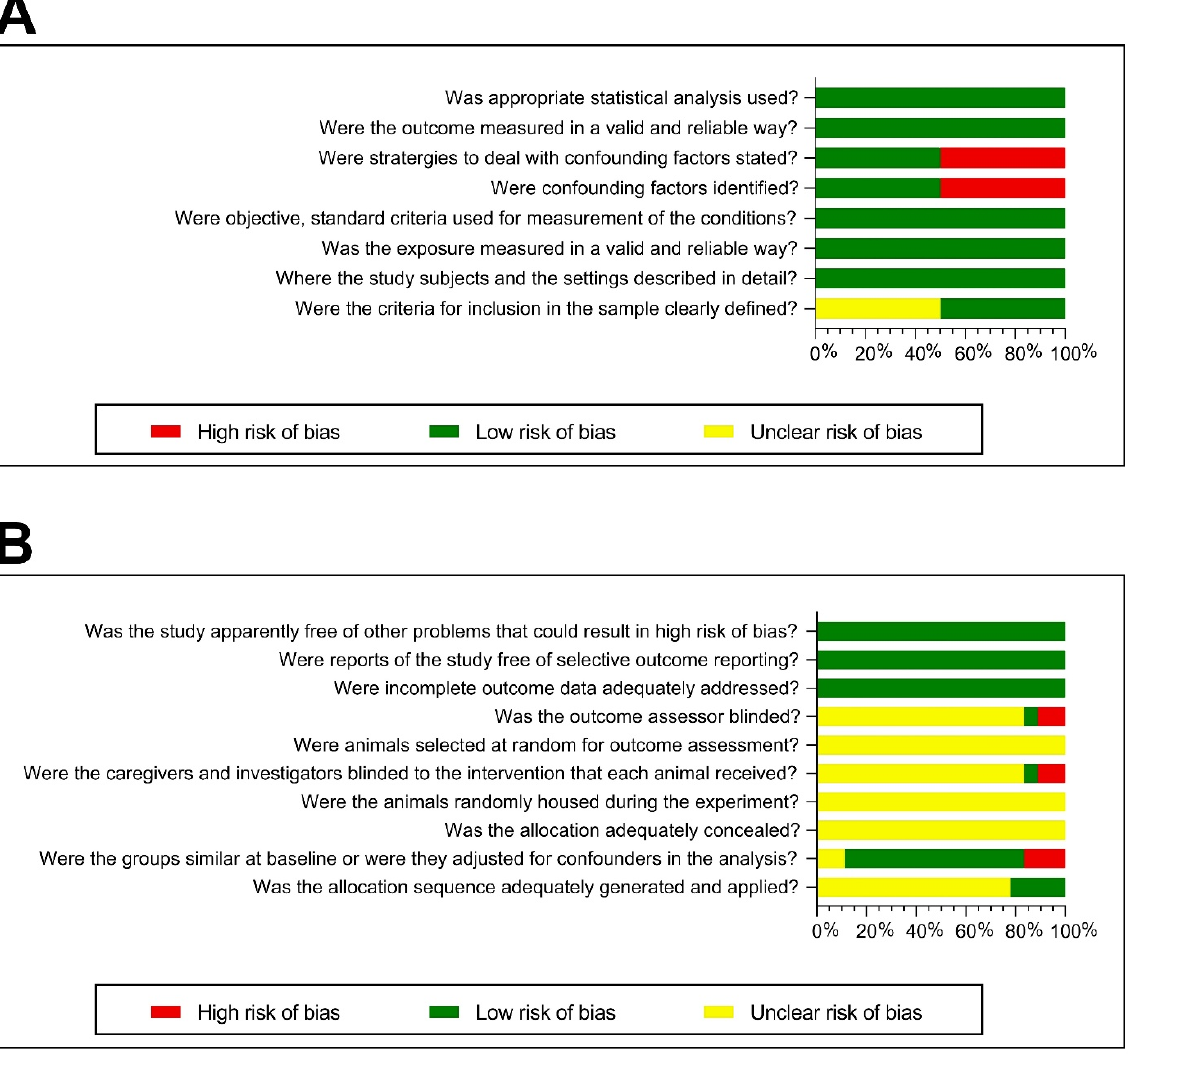
Figure 3. Summary of the risk of bias assessments of the included studies. ( A ) Risk of bias assessment for human cross-sectional studies (Joanna Briggs Institute critical appraisal tools). ( B ) Risk of bias assessment for animal studies (SYRCLE’s risk of bias tools).